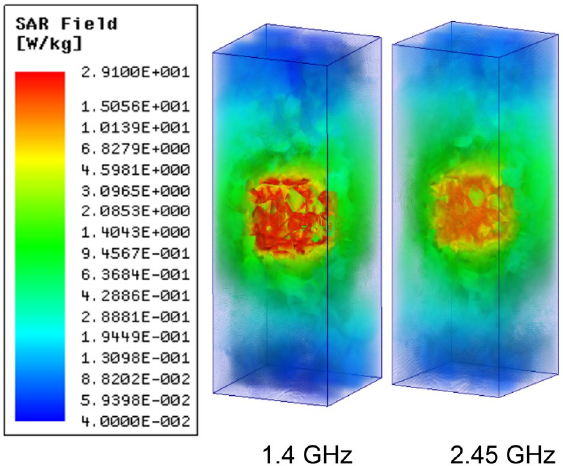
Figure 23. Simulated average SAR distribution caused by the proposed antenna over the 10 g of tissue of heart’s multi-layer model.